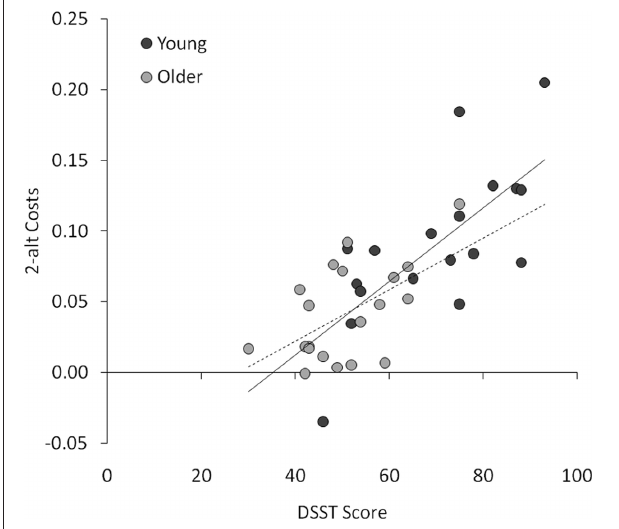
FIGURE 4 | Scatterplot of DSST scores and costs (incompatible RT : neutral RT -1) in the 2-alt task, plotted for young (solid trend line) and older (dashed trend line)